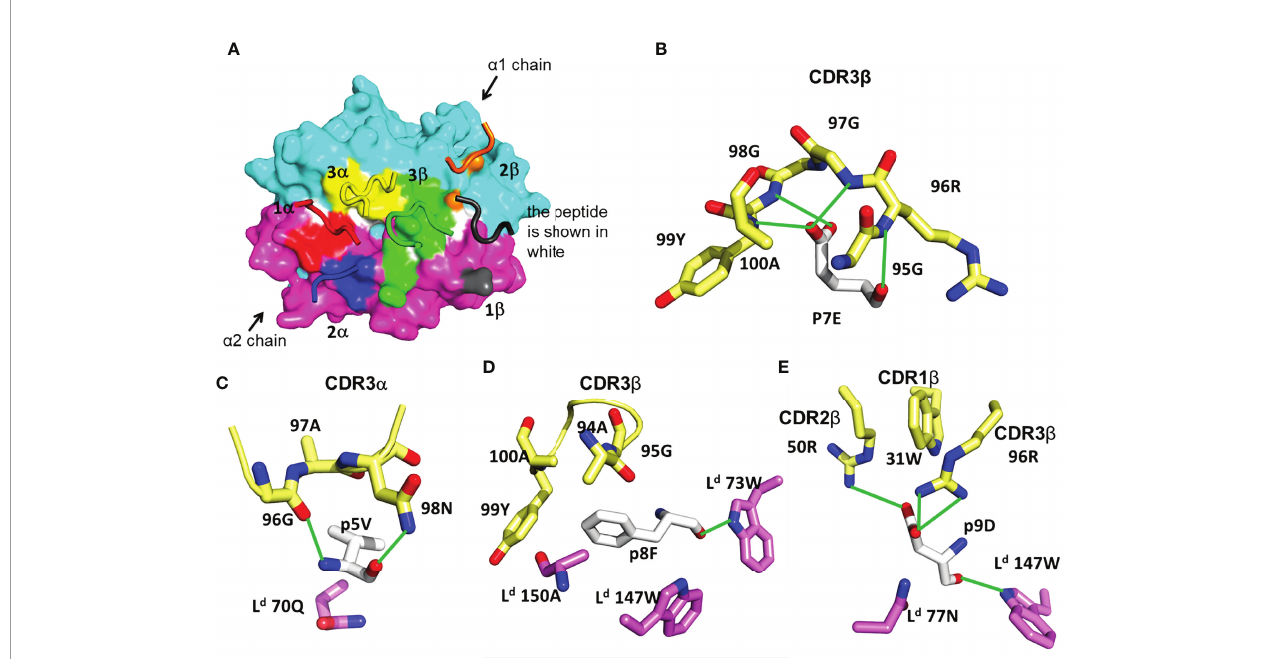
FIGURE 3 | Features of TG6 TCR bound to L d -HF10 complex. (A) TCR footprint on the solvent-accessible surfaces of the L d -HF10 complexes (L d a 1, cyan; L d a 2, magenta; peptide, white). The TCR CDR loops are colored as TCR footprint. Areas of TCR contact with pMHC ( ≤ 4.5Å) are colored as: CDR1 a , red; CDR2 a , blue; CDR3 a , yellow; CDR1 b , gray; CDR2 b , orange; CDR3 b green. (B-E), Interactions between TG6 CDRs and L d -HF10. HF10 residues are shown in white carbon stick; residues on TG6 are shown in pale yellow carbon stick; residues of L d are shown in magenta ( a 1) and cyan ( a 2) carbon stick; H-bonds and salt bridges are indicated by green lines. (B) Extensive contacts between TCR CDR3 b and p7E of the HF10 peptide. (C) Residues of both TCR CDR3 a and L d contact HF10 p5V. (D) Hydrophobic stacking of TCR CDR3 b and L d with HF10 p8F. (E) Both TG6 CDR2 b and CDR3 b form a salt bridge to p9D. L d also provides contacts. See Movie